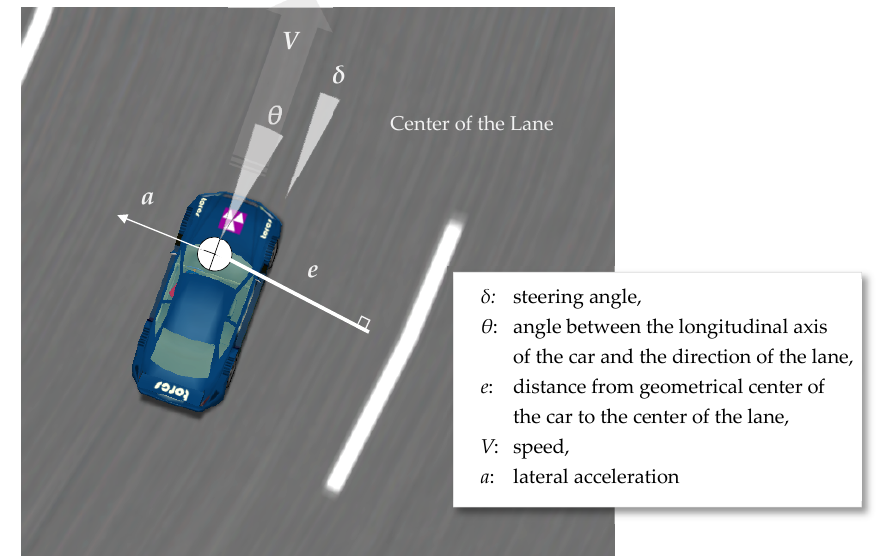
Figure 6. Tracking of the center of the car on the track during the race with friction 0.1 and 1.05 (cid:1848) (cid:3004)(cid:3019) . In the highest point of the trajectory, a crash was occurring.